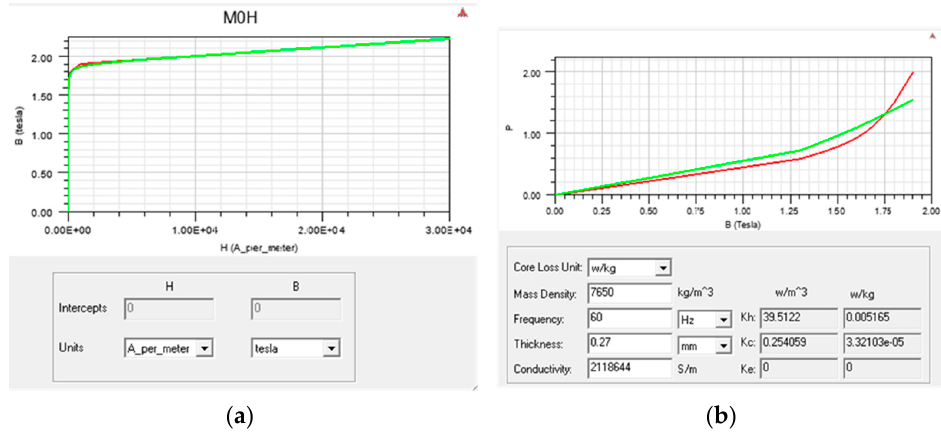
Figure A1. Magnetization curves of selected transformer magnetic core: ( a ) magnetization curve (hysteresis); ( b ) magnetization curve (material quantity relationship).